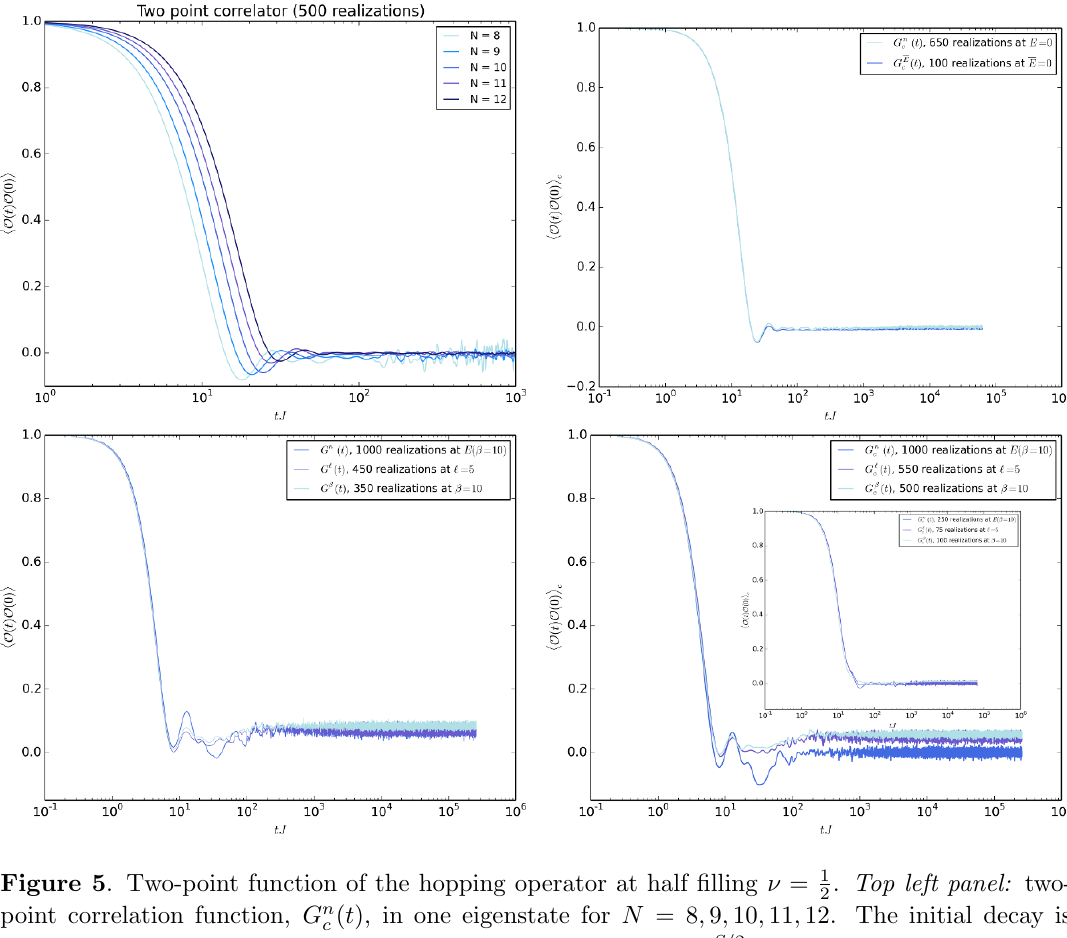
Figure 5 . Two-point function of the hopping operator at half (cid:12)lling (cid:23) = 1 . Top left panel: two- 2 point correlation function, G n ( t ), in one eigenstate for N = 8 ; 9 ; 10 ; 11 ; 12. The initial decay is c followed by late time (cid:13)uctuations around zero of typical size (cid:24) e (cid:0) S= 2 . Top right panel: comparison of microcanonical G (cid:22) E ( t ) with eigenstate G n ( t ) at the same energy for N = 10. One can appreciate c c the excellent agreement, which would only become better as the number of realizations is increased. Bottom left panel: comparison of G (cid:12) ( t ) ; G n ( t ) ; G ‘ ( t ) with parameters (cid:12); E ( (cid:12) ) and 2 ‘ = (cid:12) at N = 6. Bottom right panel: comparison of G (cid:12) ( t ) ; G n ( t ) ; G ‘ ( t ) with parameters (cid:12) , E ( (cid:12) ) and 2 ‘ = (cid:12) at N = 6 c c c (inset N =